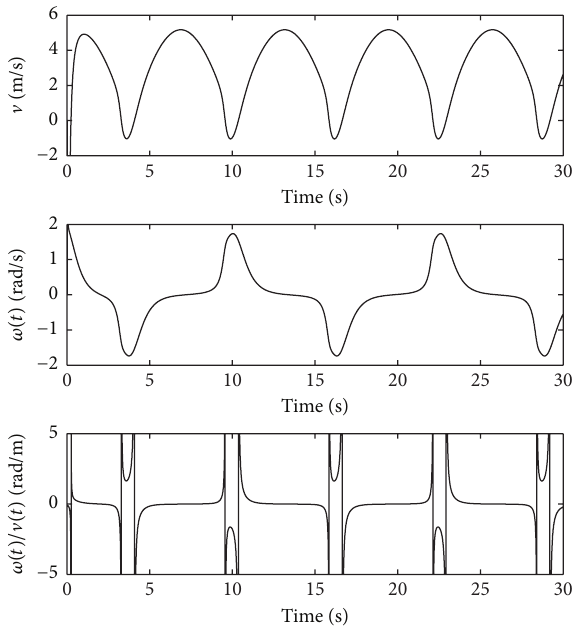
Figure 3: Controller commands for sinusoidal trajectory without saturation.